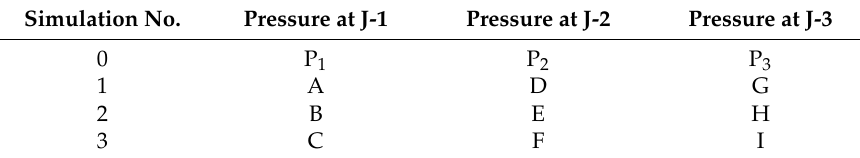
Table 6. Examples of pressure at each junction according to simulation